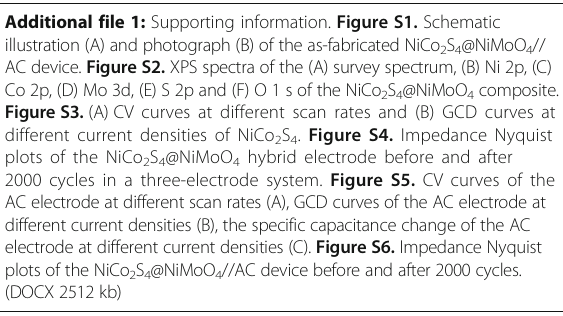
Figure S3. (A) CV curves at different scan rates and (B) GCD curves at different current densities of NiCo 2 S 4 . Figure S4. Impedance Nyquist plots of the NiCo 2 S 4 @NiMoO 4 hybrid electrode before and after 2000 cycles in a three-electrode system. Figure S5. CV curves of the AC electrode at different scan rates (A), GCD curves of the AC electrode at different current densities (B), the specific capacitance change of the AC electrode at different current densities (C). Figure S6. Impedance Nyquist plots of the NiCo 2 S 4 @NiMoO 4 //AC device before and after 2000 cycles. (DOCX 2512